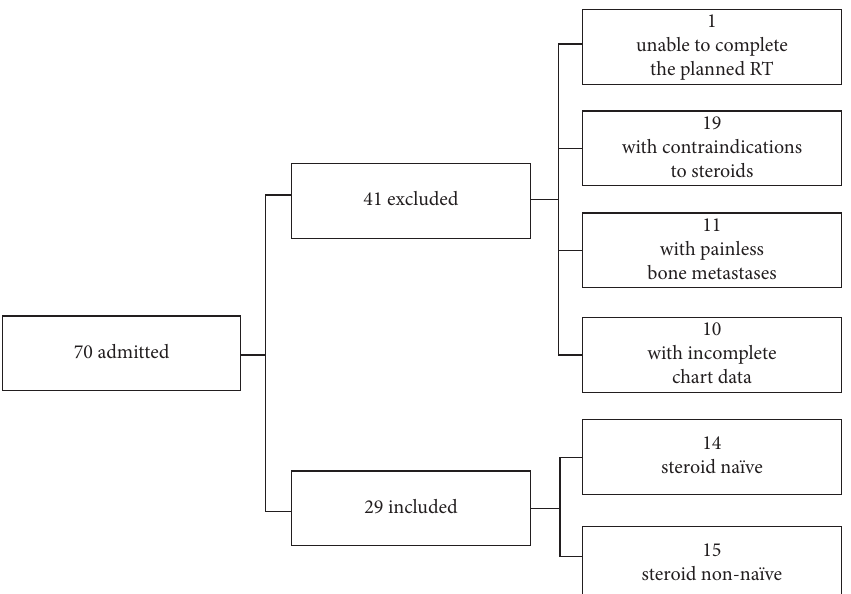
Figure 1: Flow diagram of the population assessed for eligibility, excluded patients, and included patients evaluated for pain fares and responses to dexamethasone